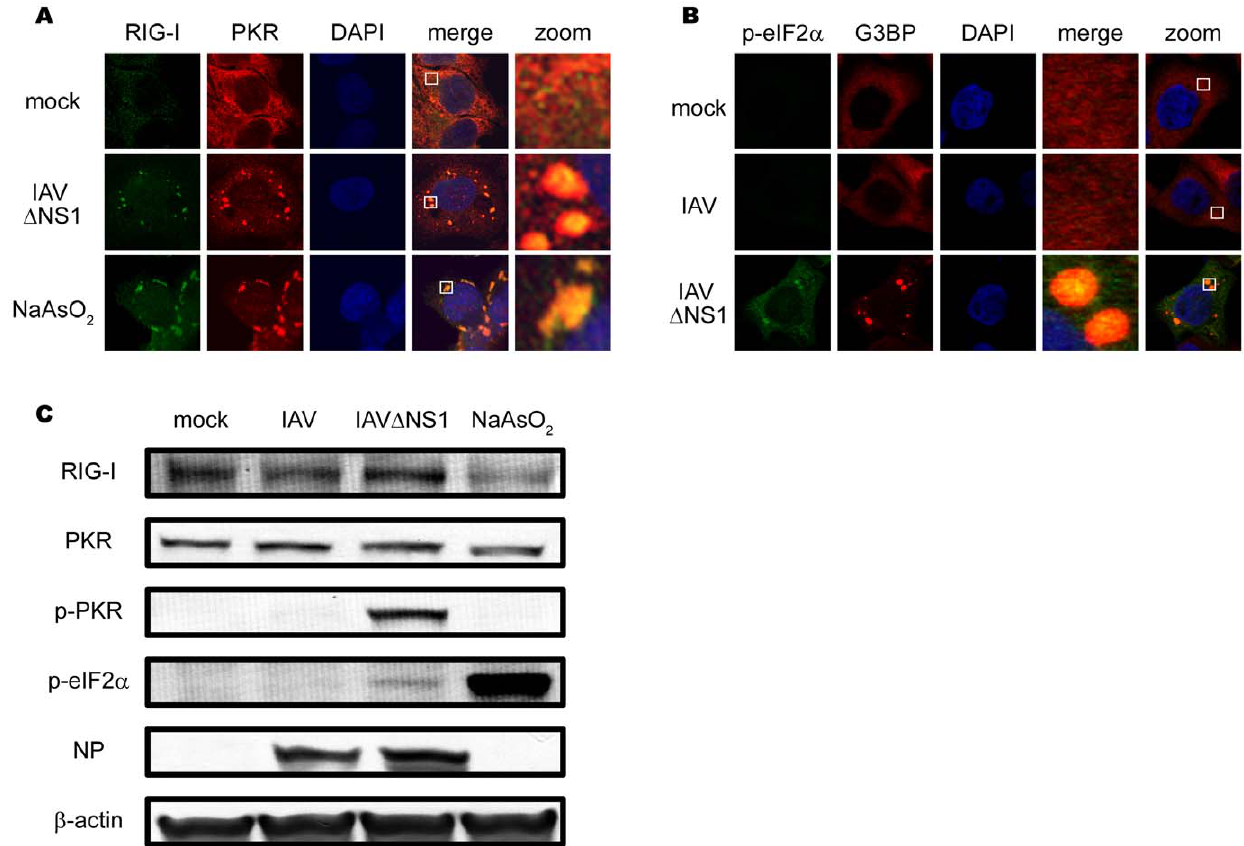
Figure 5. Localization and activation of PKR in IAVA¨ NS1-induced avSGs. ( A ) HeLa cells were mock-treated or infected with IAVA¨NS1 for 9 h or treated with NaAsO 2 for 1 h. Cells were fixed and stained with anti-RIG-I and anti-PKR antibodies (% of colocalization: 95.1% and 97.0% in IAVA¨NS1- infected and NaAsO 2 -treated cells, respectively). The zoomed images correspond to the boxed regions. ( B ) HeLa cells were mock-treated or infected with IAV or IAVA¨NS1 for 9 h and stained with anti-phospho-eIF2a´ (Ser 51) (p-eIF2a´) and G3BP (% colocalization: 0.0% and 46.5% in IAV and IAVA¨NS1- infected cells, respectively). The zoomed images correspond to the boxed regions. ( C ) HeLa cells were infected with IAV or IAVA¨NS1 for 12 h or treated with NaAsO 2 for 1 h. Cell extracts were prepared and subjected to SDS-PAGE, and immunoblotted using antibodies against RIG-I, PKR, phosphorylated PKR (Thr 446) (p-PKR), phosphorylated eIF2a´ (Ser 51) (p-eIF2a´), IAV NP, and